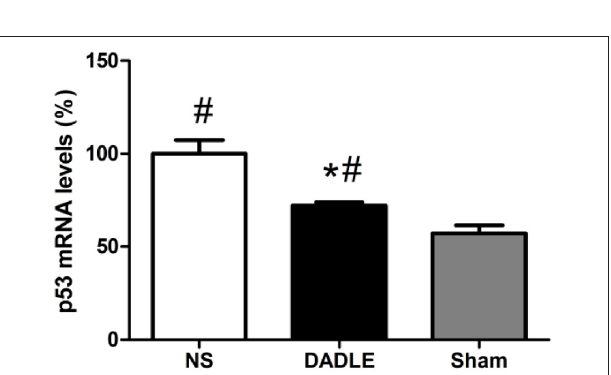
FIGURE 4 | Quantitative p53 mRNA expression through real-time PCR in the spinal cords at 48h after reperfusion. The samples of spinal cords were harvested from the spinal cord I/R and sham rabbits at 48h after operation. The transcript level of p53 were up-regulated in the normal saline-treated rabbits, while a marked reduction was shown in the DADLE group. Bars represent mean ± SD ( n = 6–8). * P < 0.05 vs. the NS group. # P < 0.05 vs. the Sham